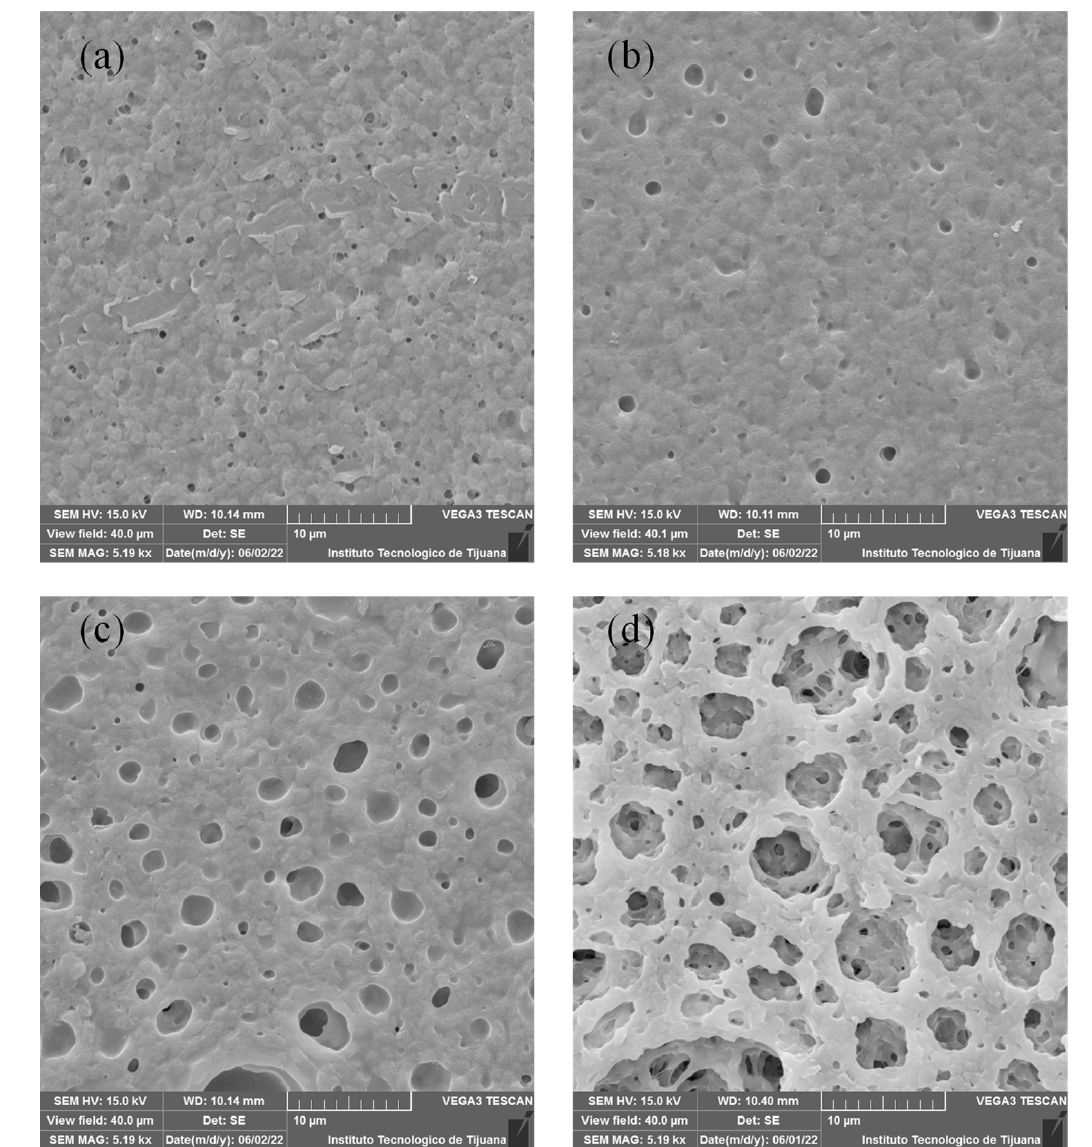
Figure 4. SEM images of membranes containing Fumion ® : ( a ) F1, ( b ) F2, ( c ) F3 y ( d ) F4.